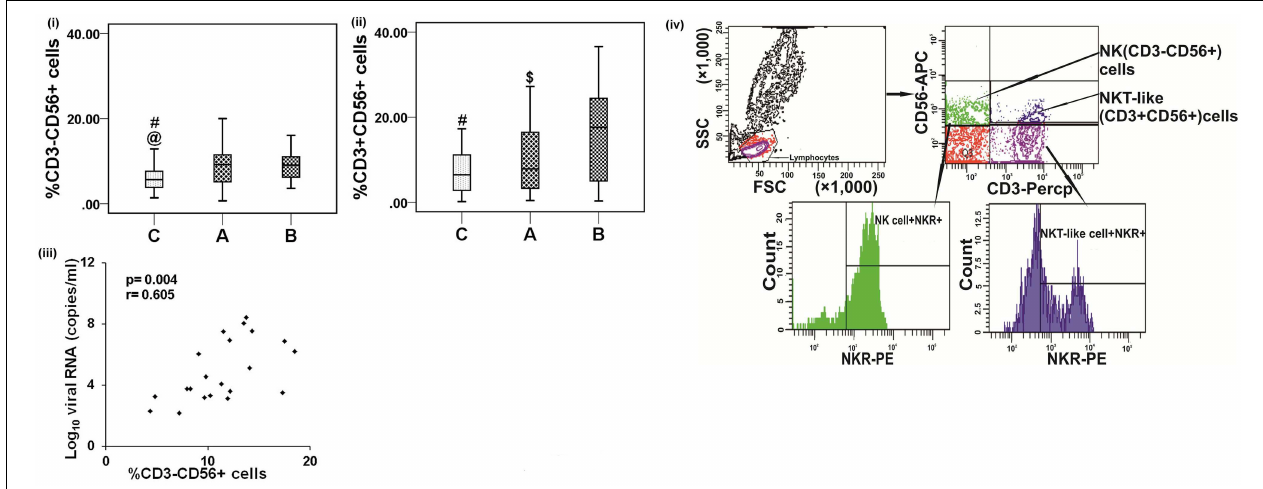
FIGURE 2 | Distribution of NK and NKT-like cells. Percentages of the lymphocytes mentioned were determined from the whole blood of 56 control subjects, 56 acute, and 31 convalescent patients. Box plots show the percentages of (i) NK (CD3 − CD56 + ) cells and (ii) NKT-like (CD3 + CD56 + ) cells. Boxes represent interquartile ranges, vertical lines represent ranges and horizontal lines represent medians. Nonparametric Kolmogorov–Smirnov test was used for intergroup comparison. @ denotes A (acute) vs. C(control), # denotes B (convalescent) vs. C (control) and $ denotes A (acute) vs.C (convalescent). p < 0 . 05 is considered significant. (iii) Spearman correlation co-efficient shows positive correlation between viral load and NK (CD3 − CD56 + ) cells from acute patients, where p < 0 . 05 is considered significant and r > 0 . 5 is considered as positive. (iv) Plots showing the strategy used for gating lymphocyte population, NK and NKT-like cells. Lymphocytes are gated in FSC vs. SSC plot, upper left quadrant (Q1) of contour plot shows NK cells (CD3 − CD56 + ) and upper right quadrant (Q2) shows NKT-like cells (CD56 + CD3 + ). NK/NKT-like cells were gated within the lymphocytes as per CD56 and CD3 staining pattern and NKRs were gated on NK/NKT-like cells individually. Histogram plots represent the percentage of NKRs + (NK receptors) NK/NKT-like cells.